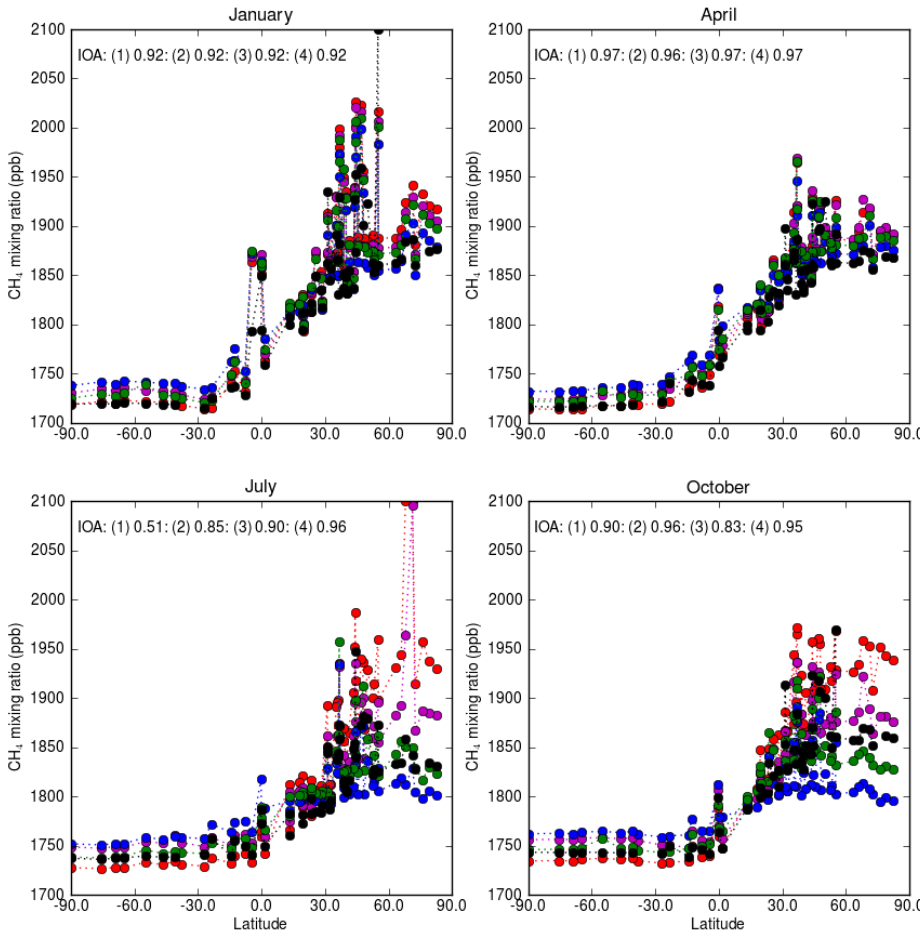
Figure 3. Comparison of the latitudinal distribution of the surface atmospheric methane mixing ratio (in ppb) as observed (black) and from the HadGEM2 runs using the following wetland emission inventories, (1) FUNG (red), (2) TRANSCOM-FUNG (magenta), (3) JULES (blue), and (4) JULES-GIEMS (green) between the years 2000 and 2010 for the months January, April, October and December. The index of agreement (IOA) is shown for each run (see Sect. 3 of the Supplement for the definition of the